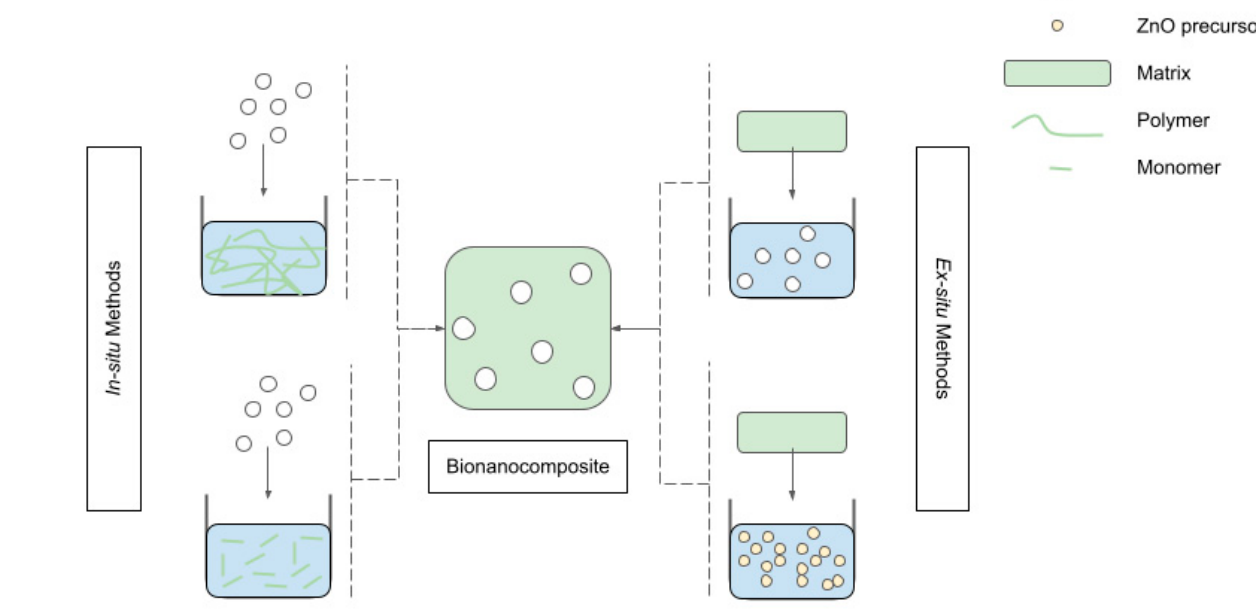
Figure 4. Schematic representation of BNCs’ preparation techniques.